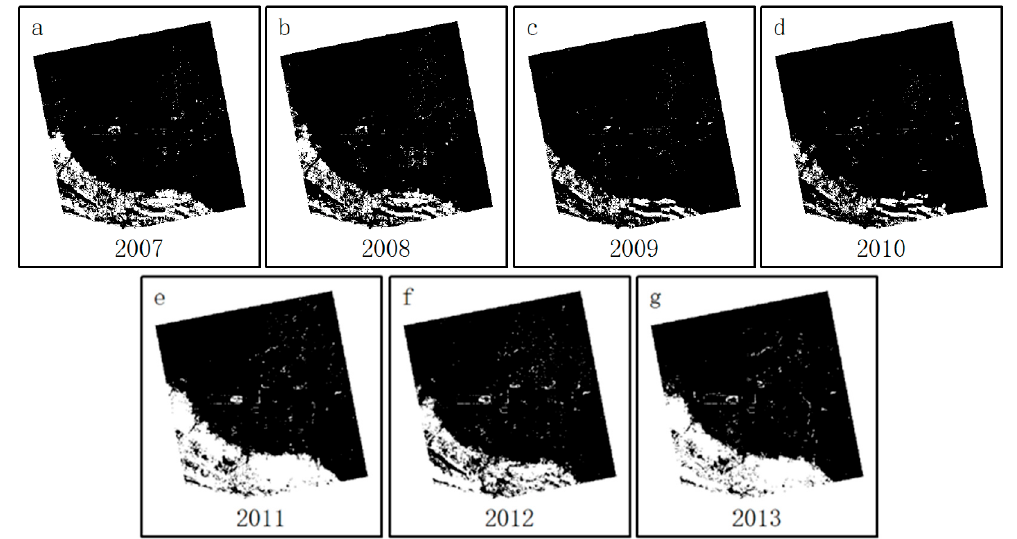
Figure 5. Flood water spatial coverage from 2007 to 2013 ( a – g ). The Tonle Sap Lake in the lower left corner of the images were removed.